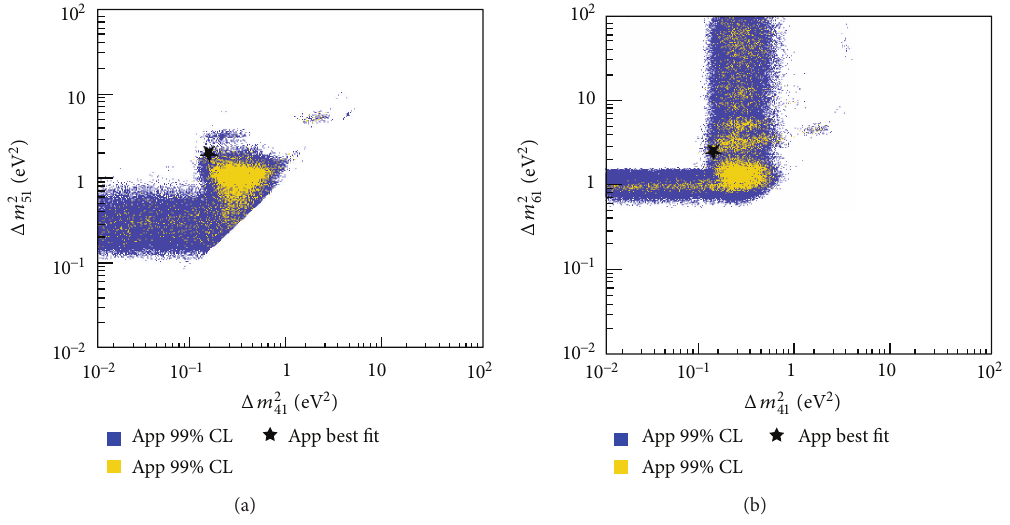
Figure 11: The Δ𝑚 2 51 versus Δ𝑚 2 41 and Δ𝑚 2 61 versus Δ𝑚 2 41 correlations from fits to appearance data in a ( 3 + 3 )